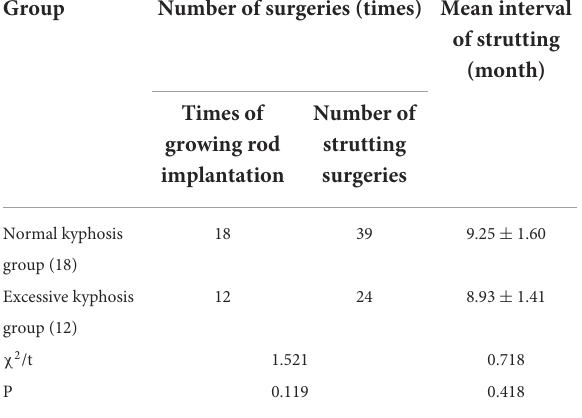
TABLE 1 Comparison of number and interval of surgeries between the two groups.